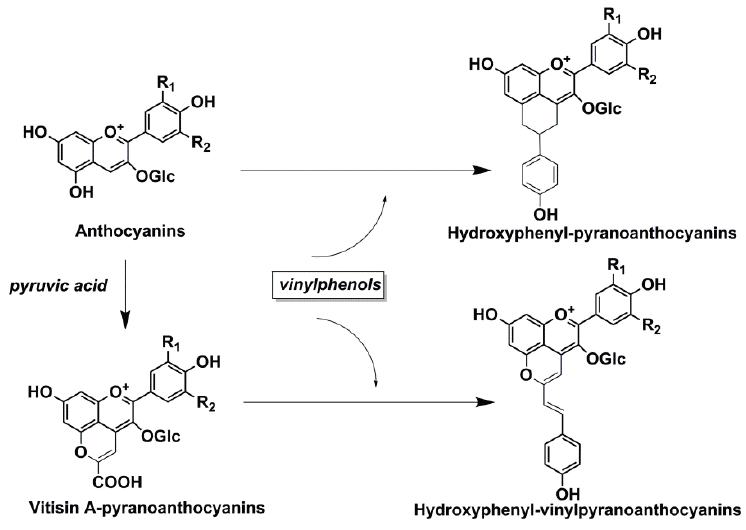
Figure 3. Formation of the anthocyanin-vinylphenol adducts